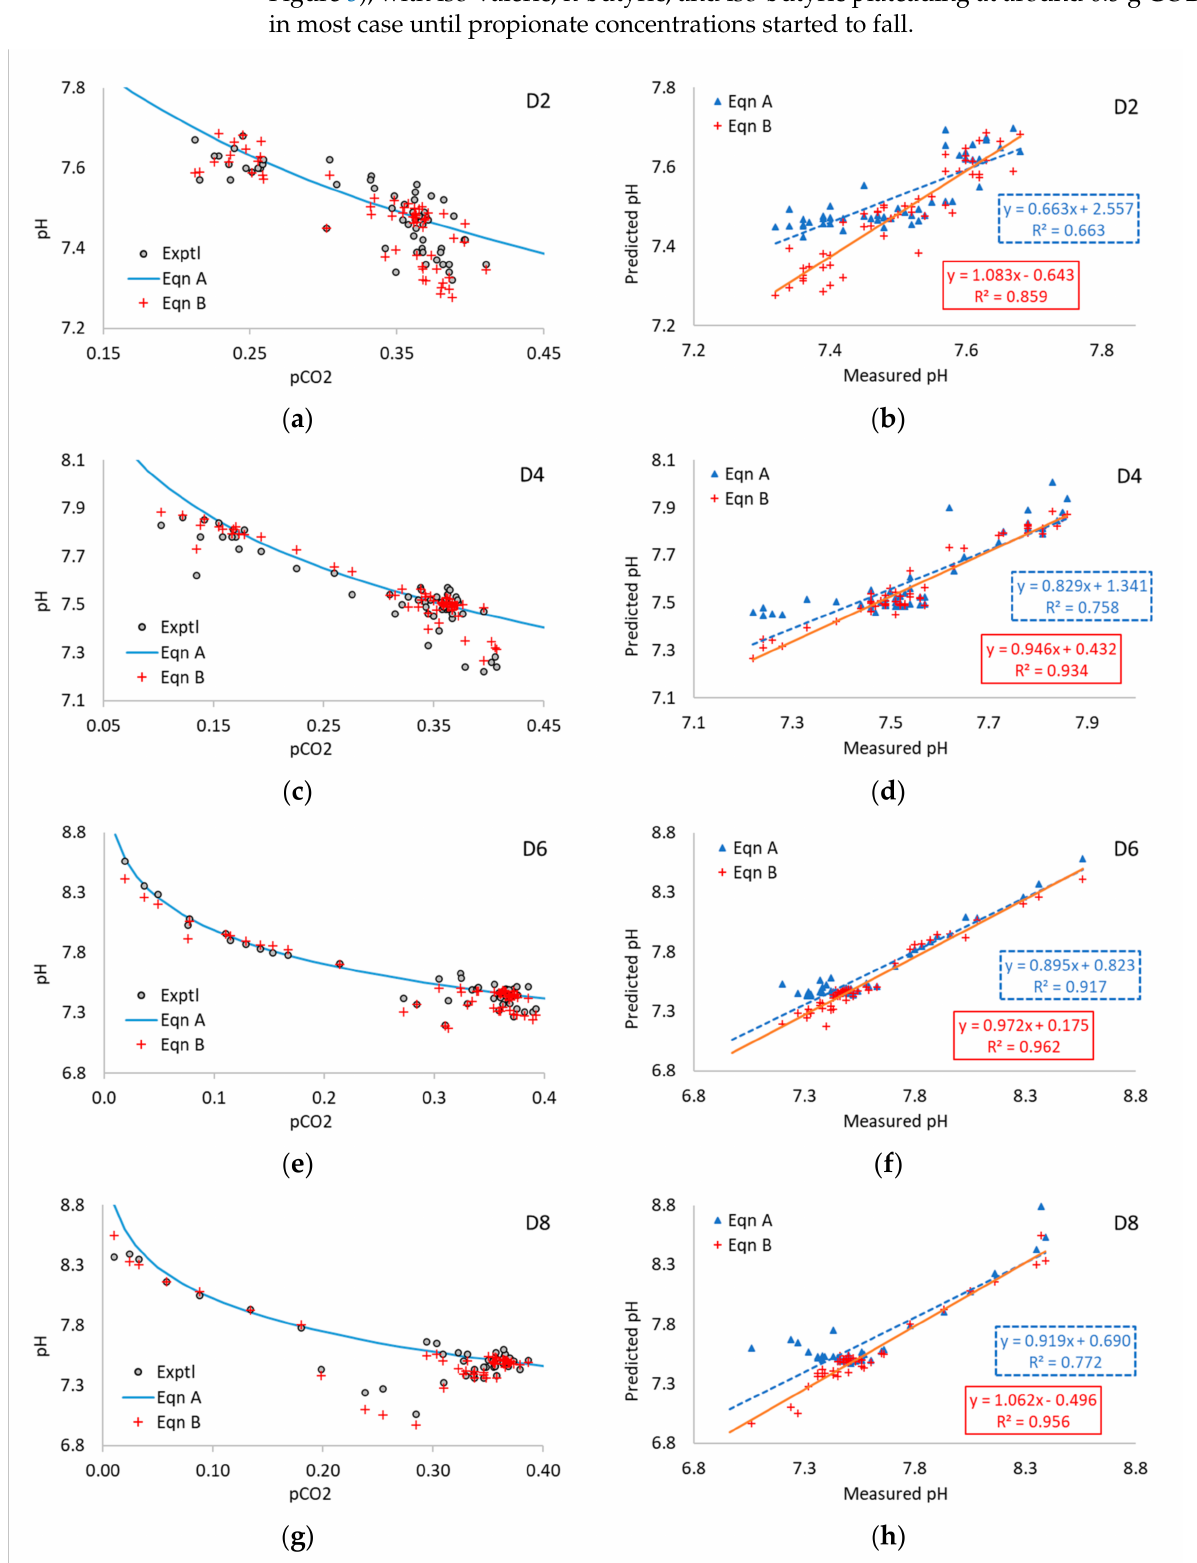
Figure 5. Experimental pCO 2 and pH values and predicted pH from Equations A and B in digesters D2 ( a , b ), D4 ( c , d ), D6 ( e , f ), and D8 ( g , h ) during mesophilic anaerobic digestion of sewage sludge at varying H 2 addition